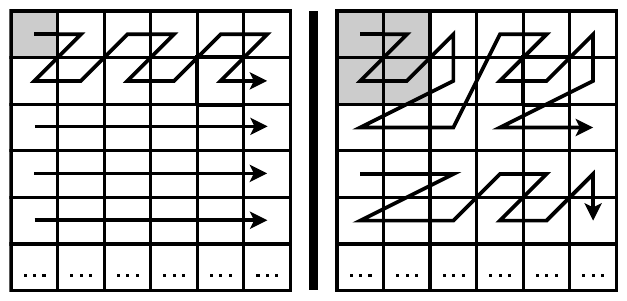
Figure 7. Zigzag block processing order [15].